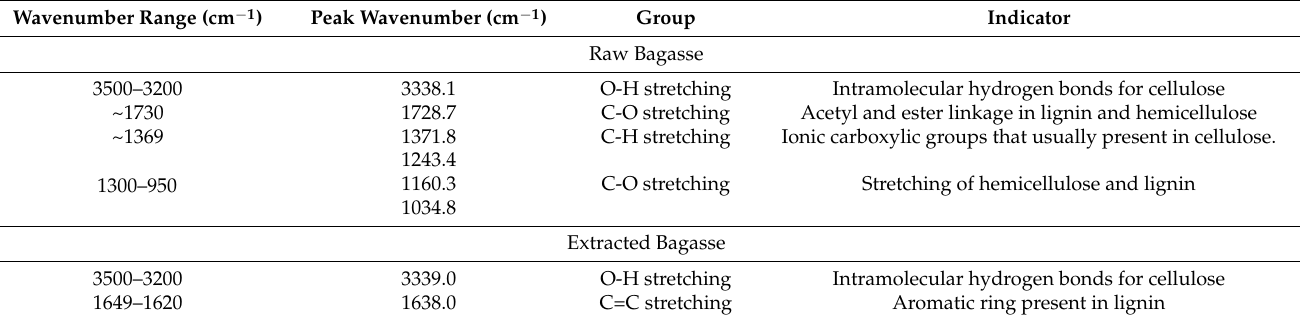
Table 4. Bagasse functional groups based on FT-IR